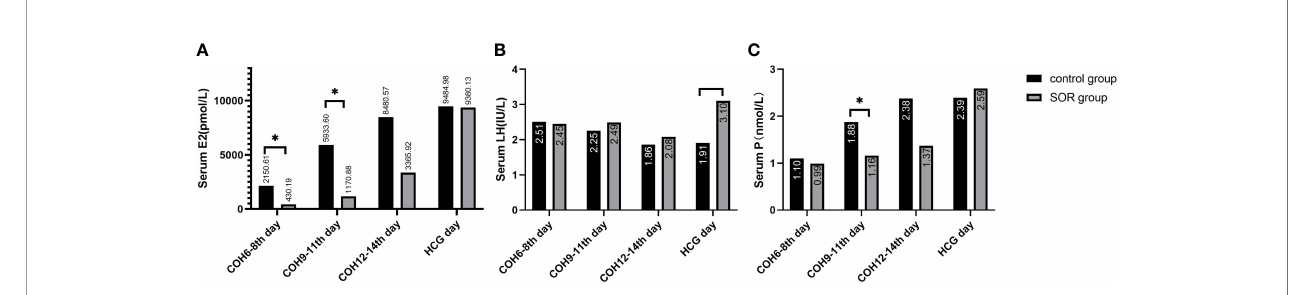
FIGURE 5 | (A) Level of serum E2 during the COH process in the antagonist group; (B) Level of serum LH during the COH process in the antagonist group patient; (C) Level of serum P during the COH process in the antagonist group patient (note: (1) *Indicates statistically signi fi cant difference (P < 0.05); (2) n (SOR group) = 54, n (control group) = 54).